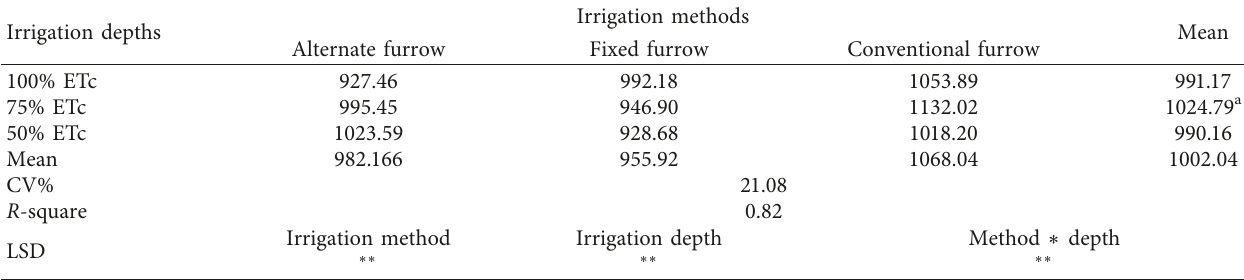
Table 4: Sesame yield (kg/ha) response to deficit irrigation and combined mean yield over years during the cool cropping season.